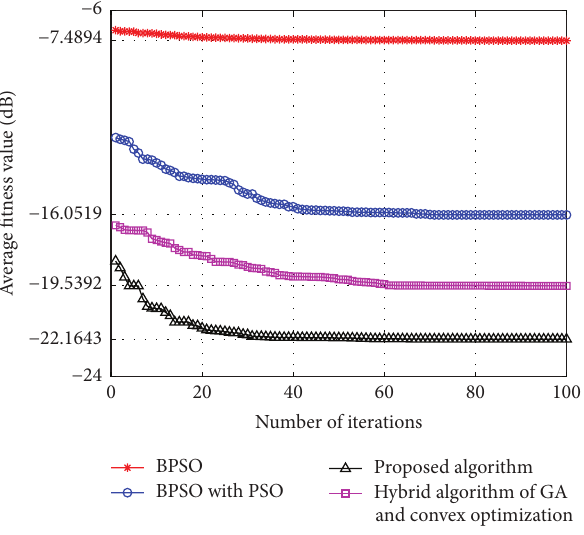
Figure 8: Convergence curves of different